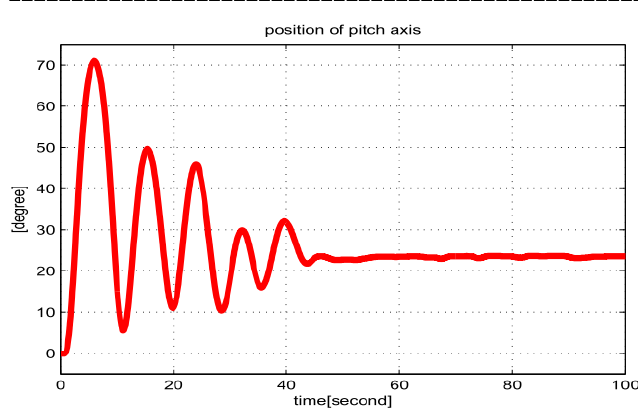
Fig. 2. Angular pitch position when proportional controller with gain 10 was applied on the main motor.